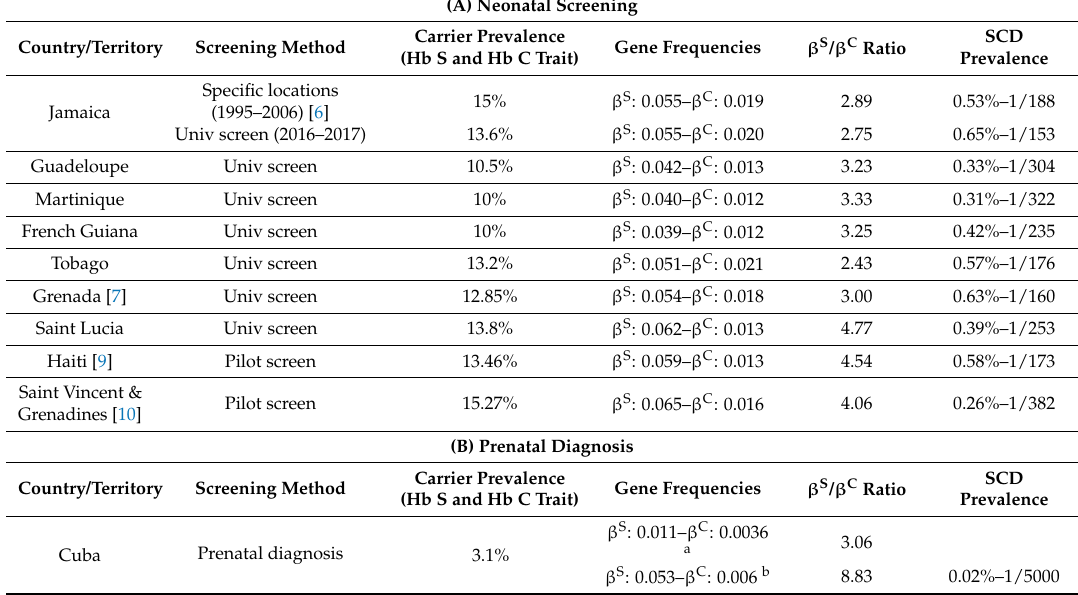
Table 3. SCD birth prevalence in the Caribbean countries and territories. (A) Neonatal